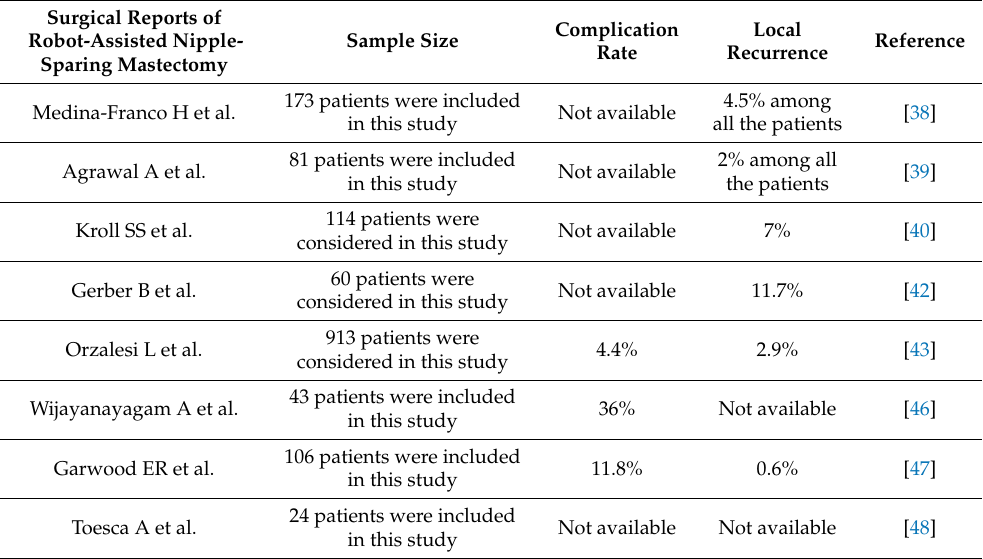
Table 1. Robot-assisted nipple-sparing mastectomy: Clinical Outcomes in terms of complication rate and local